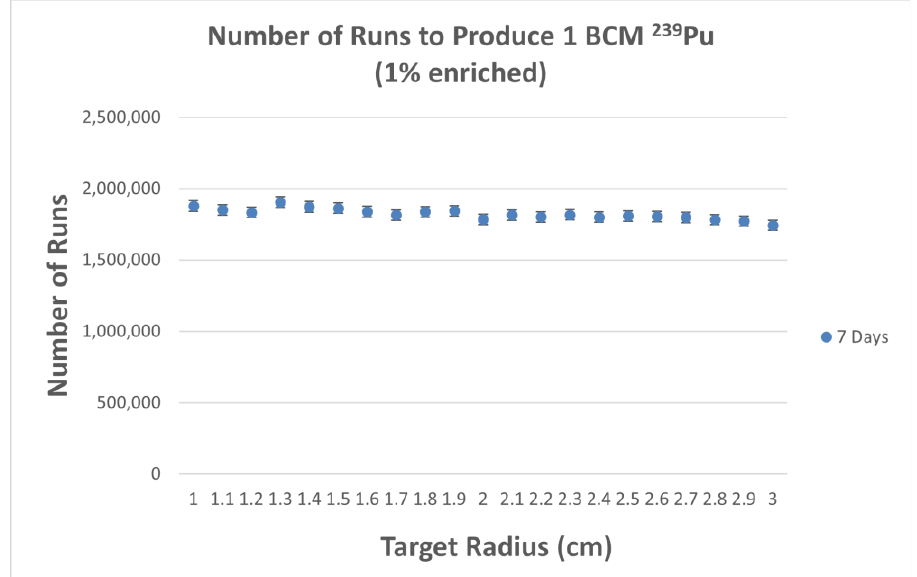
Figure 8. Number of runs to produce 1 BCM of 239 Pu versus target radius for a fixed target height of 10 cm.